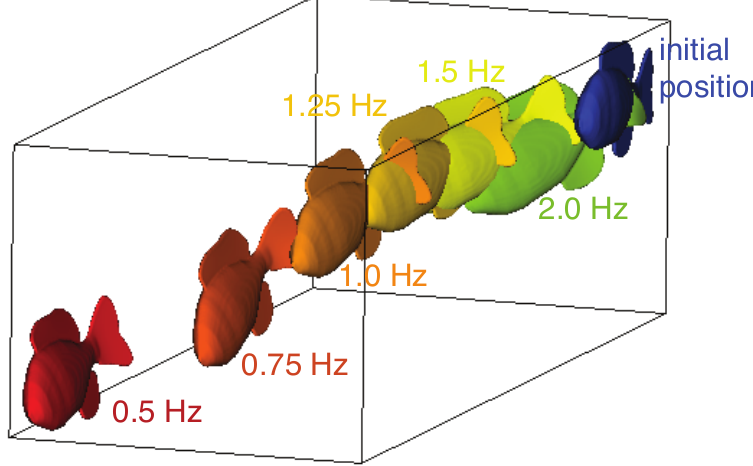
Figure 4. The end position of the fish model after eight actuation cycles for f = 0.5 Hz (red), 0.75 Hz (red-orange), 1.0 Hz (orange), 1.25 Hz (yellow-orange), 1.5 Hz (yellow), and 2.0 Hz (green). Initial position in blue.